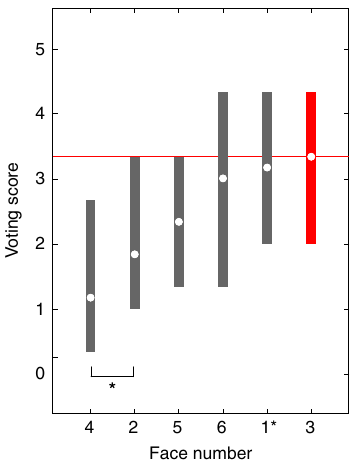
Fig. 6 Results of perceptual scaling in the target-absent